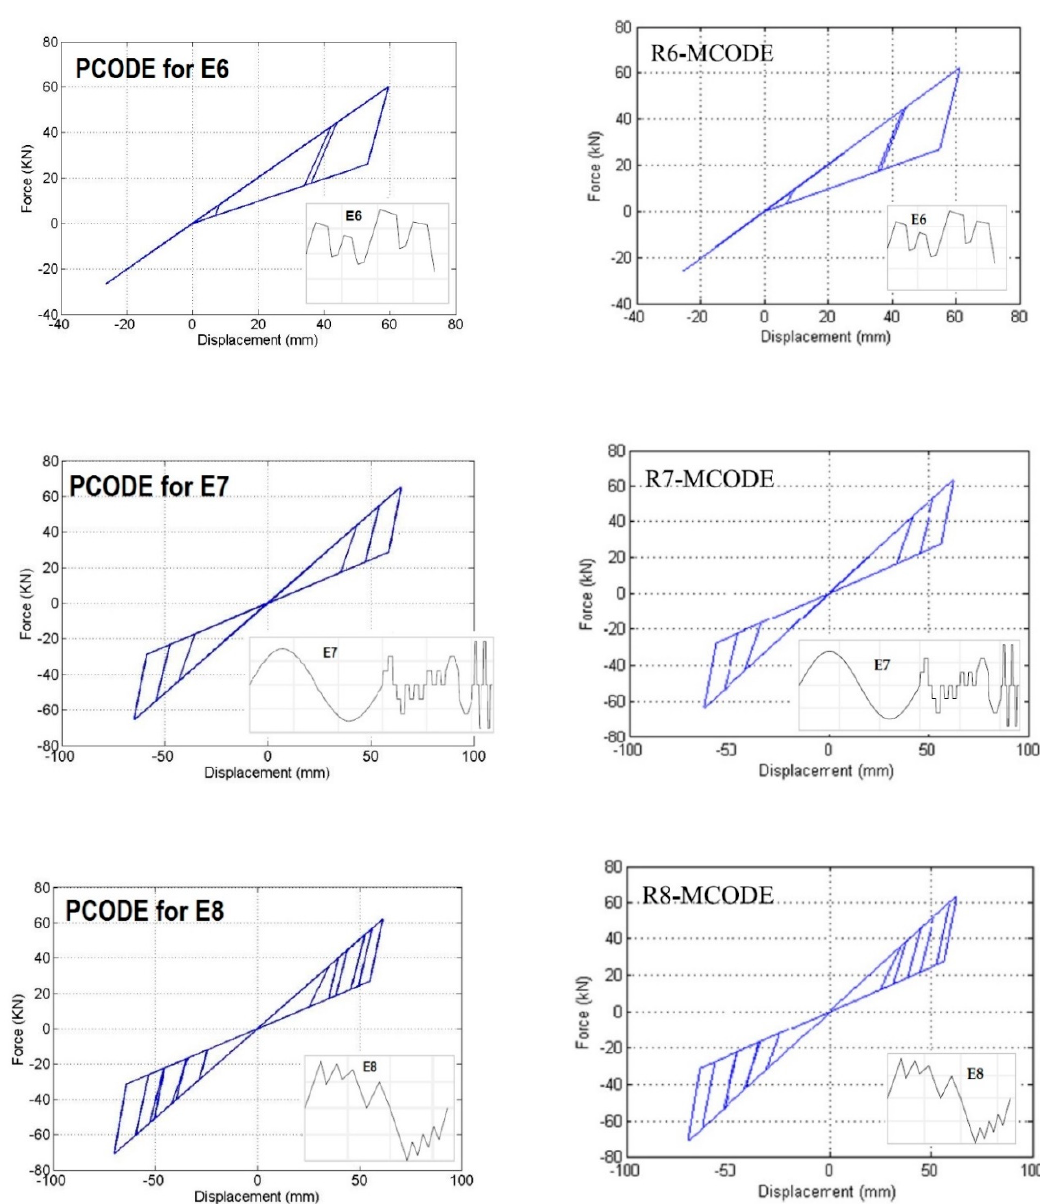
Figure 6. Hysteresis curve plotted by this paper’s written code (PCODE), and with Hedayati Dezfuli and Alam (MCODE) [7].